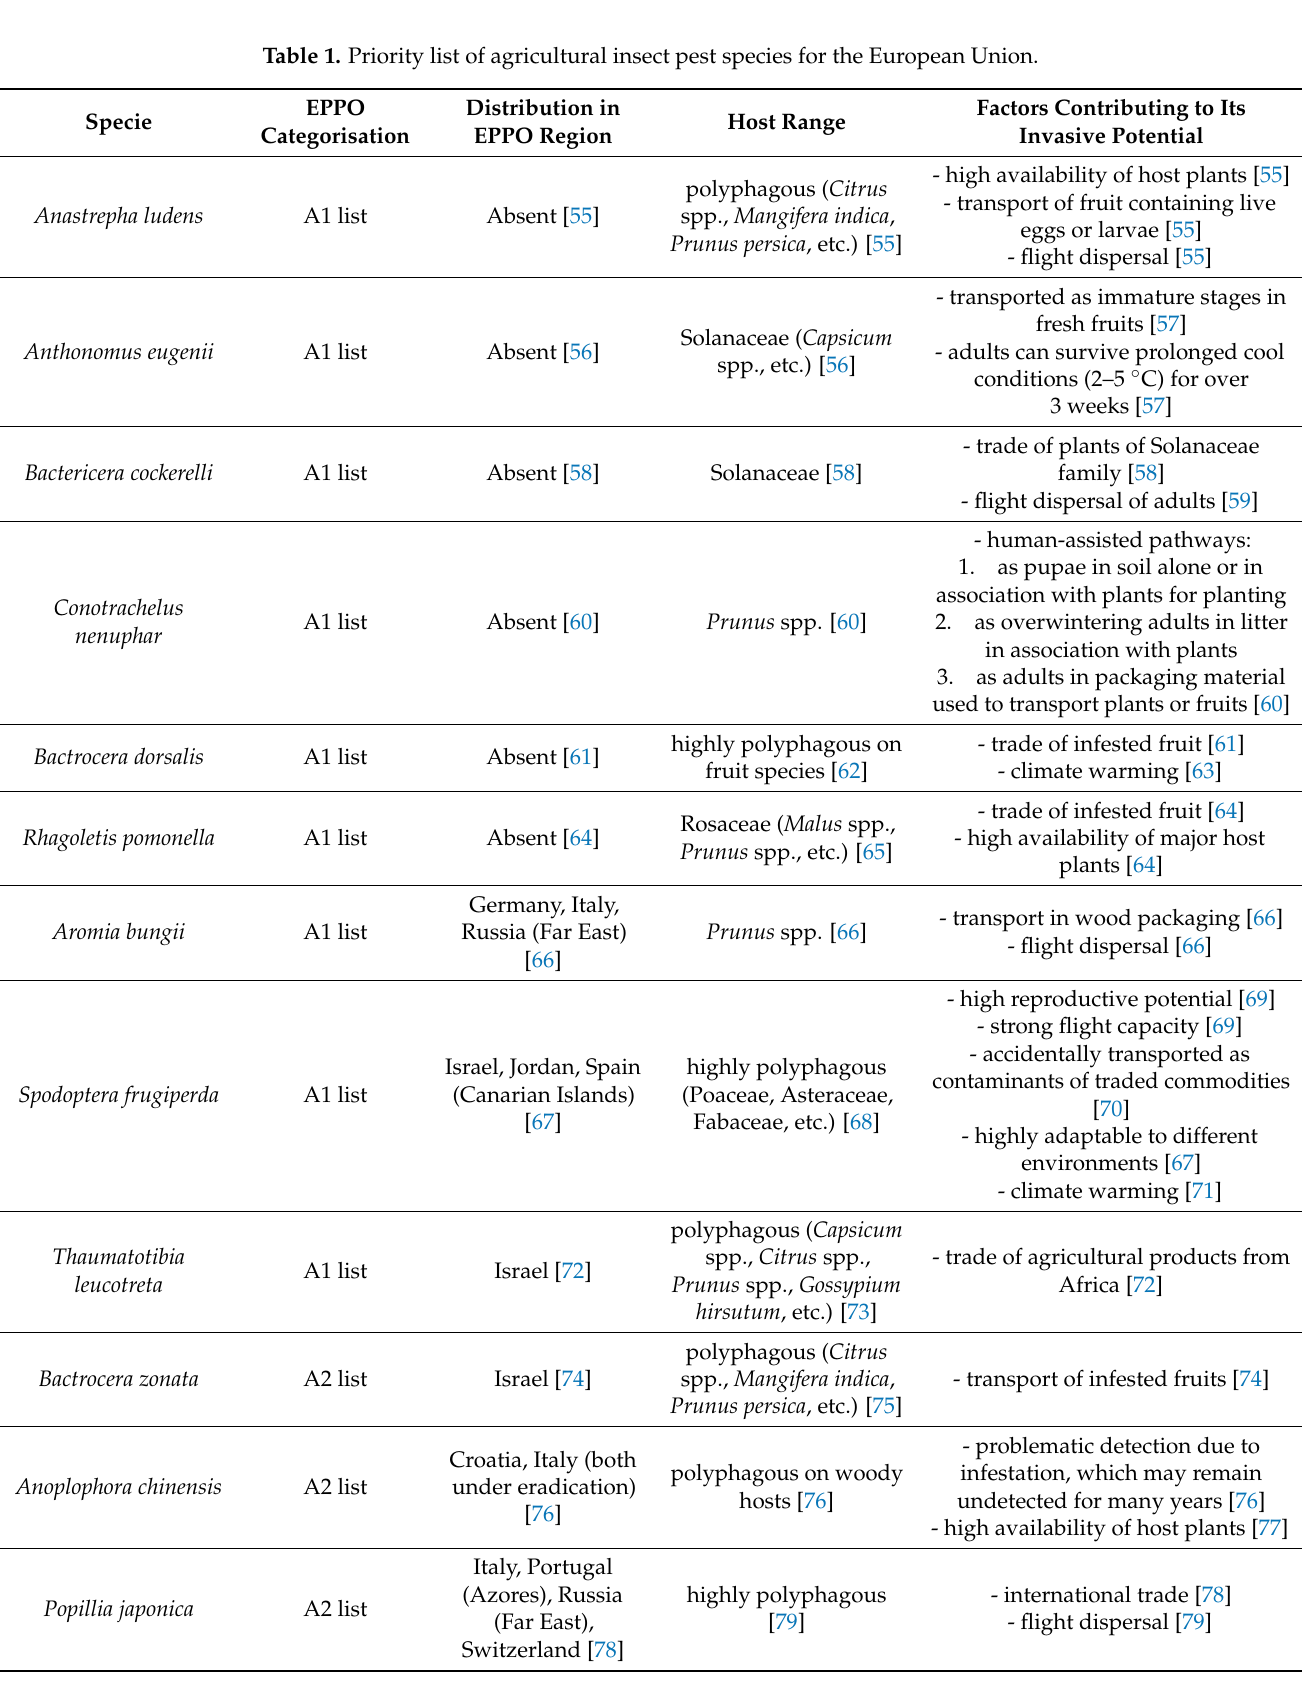
Table 1. Priority list of agricultural insect pest species for the European